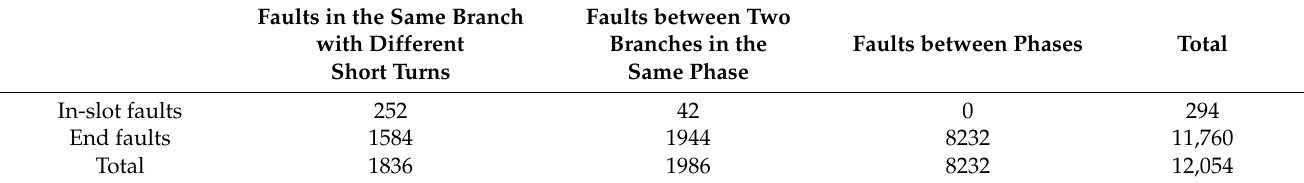
Table 2. The number of possible internal short-circuit faults in rotor windings.